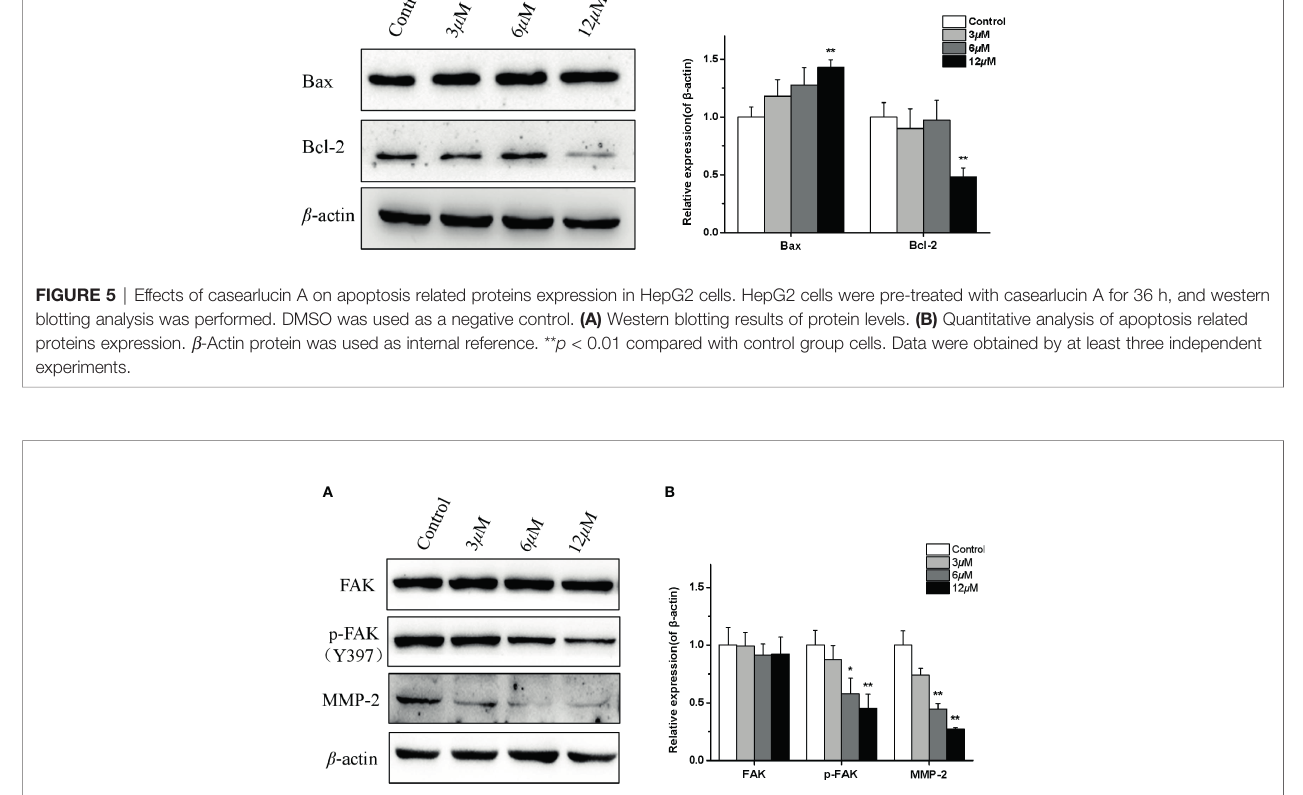
FIGURE 6 | Effects of casearlucin A on metastasis-related proteins expression in HepG2 cells. HepG2 cells were pre-treated with casearlucin A for 36 h, and western blotting analysis was performed. DMSO was used as a negative control. (A) Western blotting results of protein levels. (B) Quantitative analysis of metastasis- related proteins expression. b -Actin protein was used as an internal reference. * p < 0.05, and ** p < 0.01 compared with control group cells. Data were obtained by at least three independent